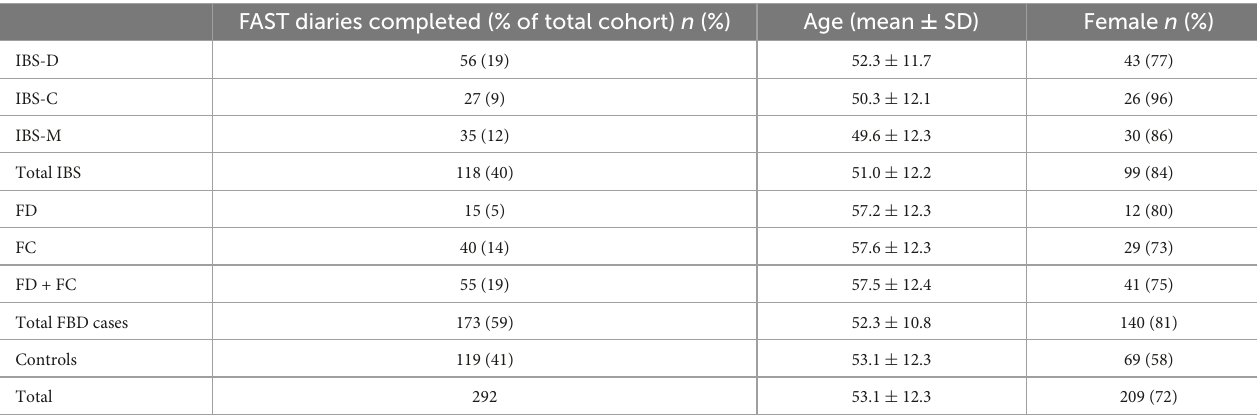
TABLE 1 Demographic characteristics of participants with complete food and symptom times (FAST) diaries. FAST diaries completed (% of total cohort) n (%)